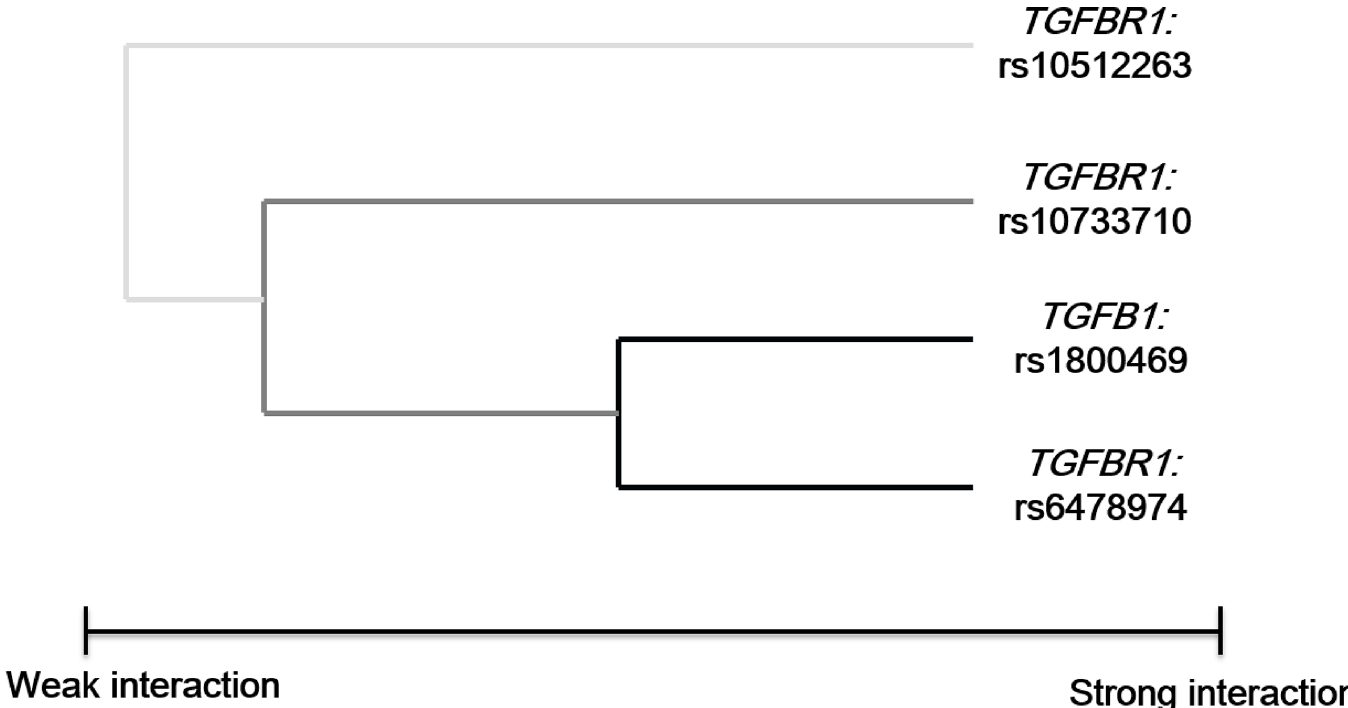
Fig 3. Interaction dendrogram for EC. The loci that strongly interact to each other appear close together at the branches of the tree (black line), whereas the loci with weak interaction appear distant from one another (grey